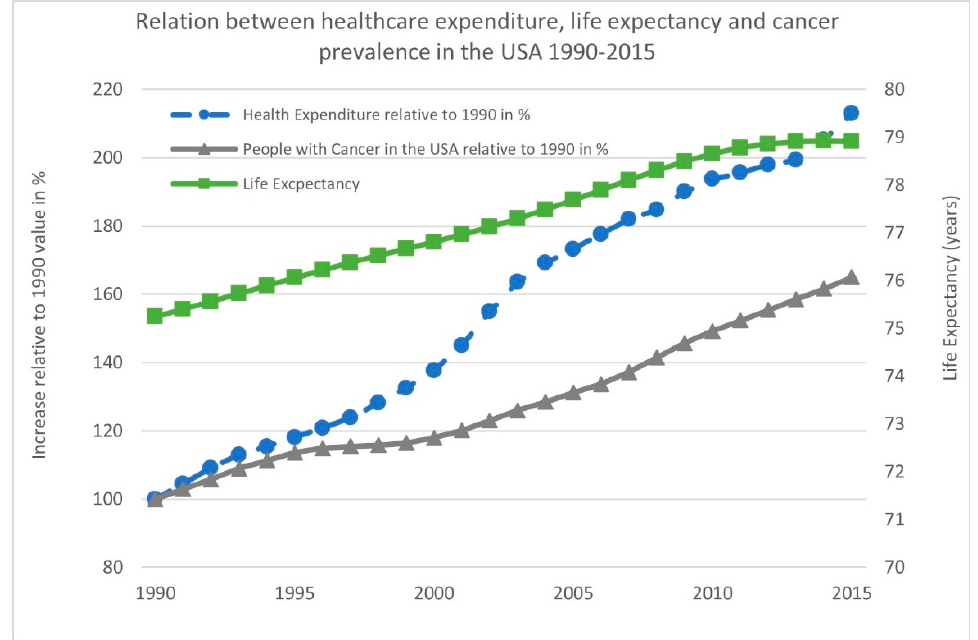
Figure 2. Relation between healthcare expenditure, life expectancy, and cancer prevalence in the USA from 1990 to 2015.